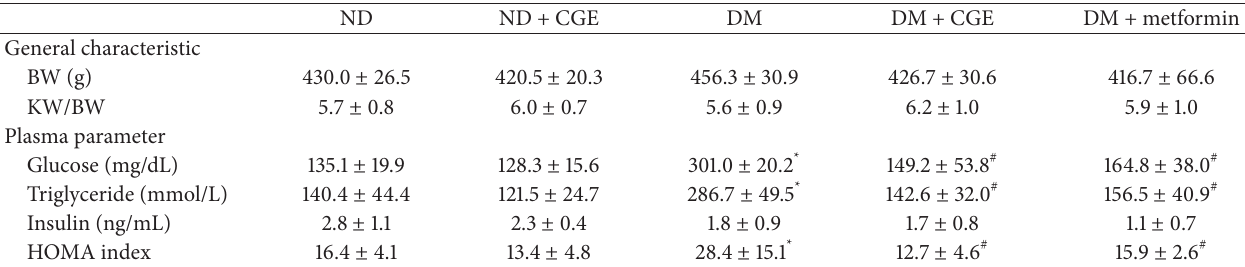
Table 2: General characteristics and plasma parameters of experimental rats at the end of week 12.